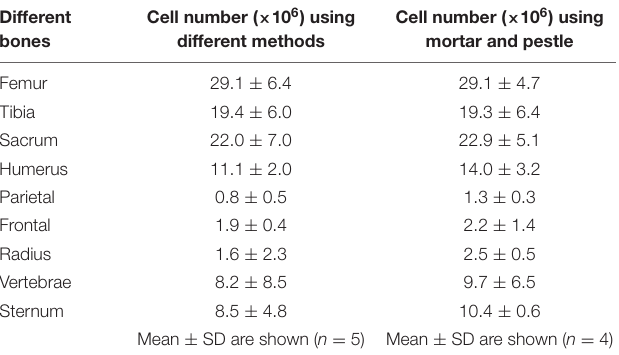
TABLE 1 | BM yield from different bones. Different Cell number ( × 10 6 ) using bones different methods